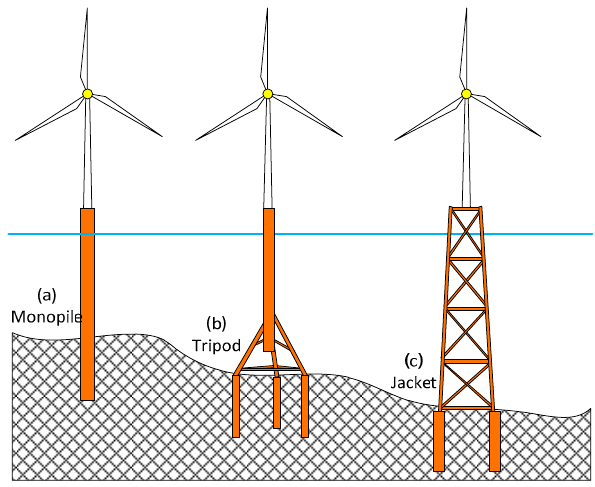
Figure 1. Common types of support structures for offshore wind turbines.